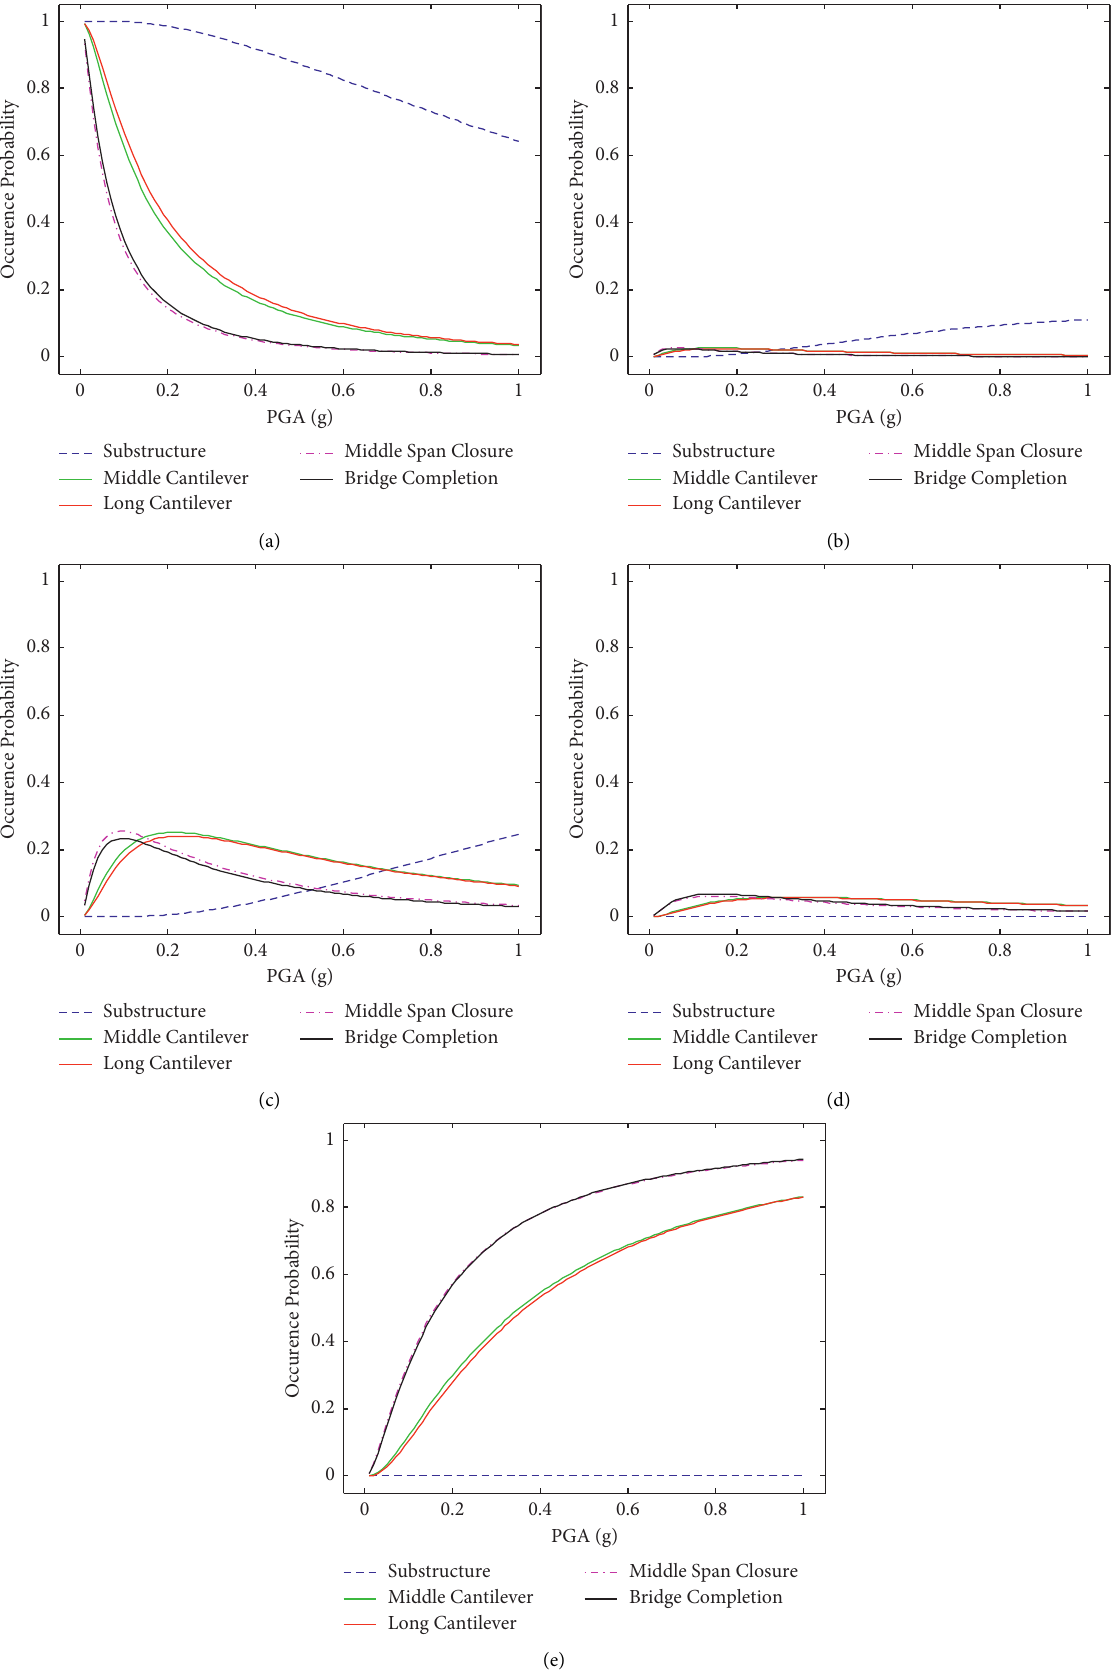
Figure 8: Occurrence probability curves of different damage states. Occurrence probability of (a) no damage state, (b) slight damage state, (c) moderate damage state, (d) extensive damage state, and (e) collapse damage